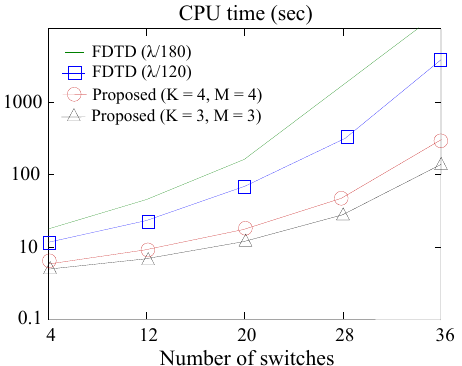
Figure 10: Magnitude of different S -parameters as a function of the switches number.